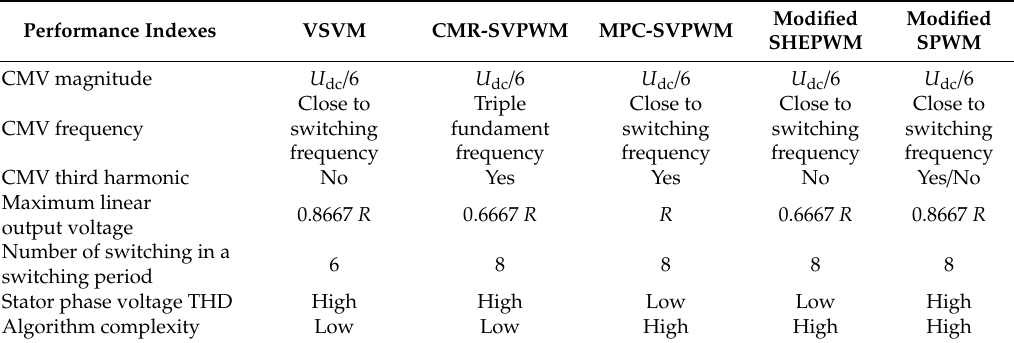
Table 4. Features of five PWM methods for common-mode